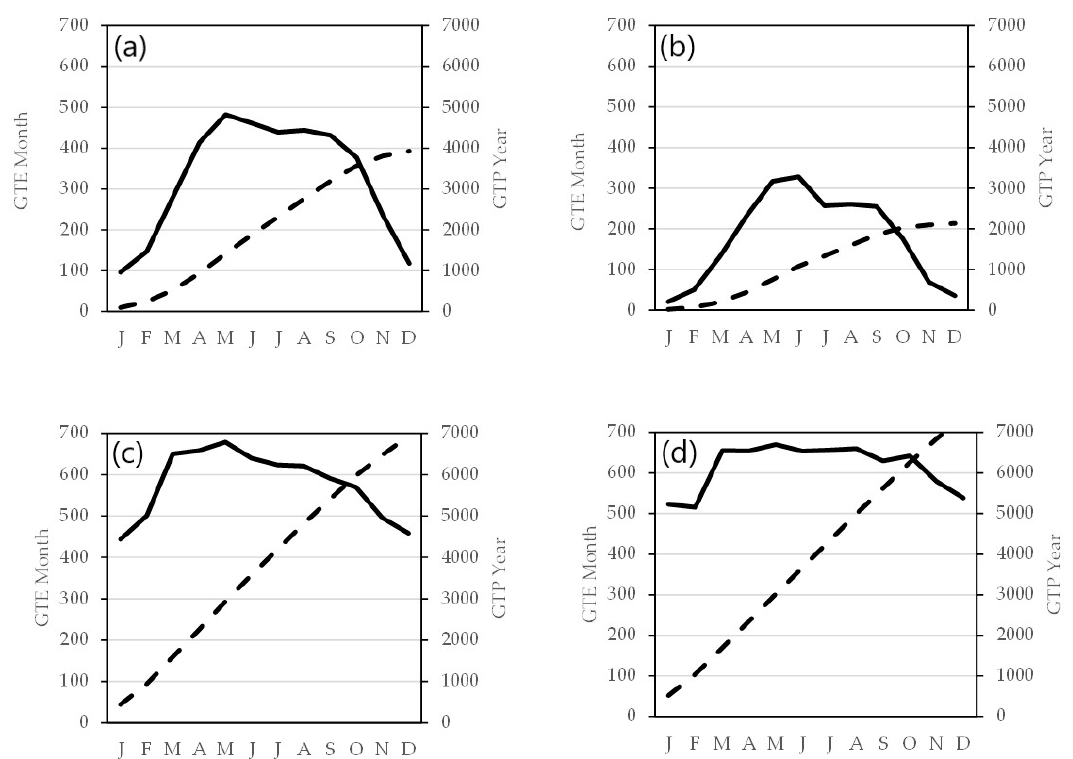
Figure 4. Distribution of the thermal efficiency of the greenhouse per month (GTE) and the accumu- lated along year (GTP) using data from meteorological stations of the State of Mexico; ( a ) Tecamac, ( b ) Metepec, ( c ) Tonatico, and ( d ) Tejupilco.